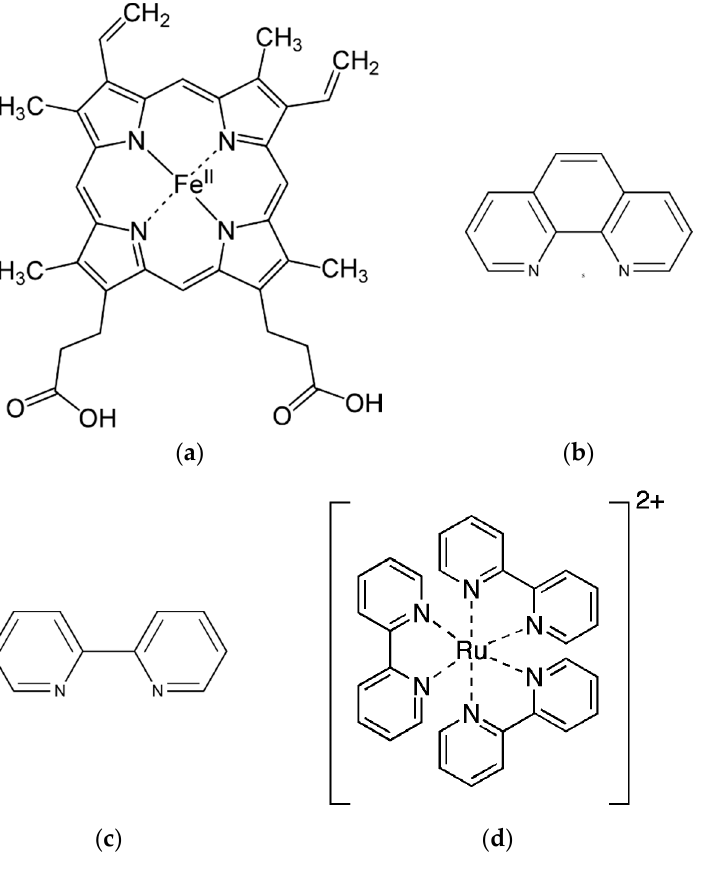
Figure 12. Examples of conjugated π orbital systems. ( a ) heme B, ( b ) 1,10-phenanthrolene, ( c ) 2,2 ′ -bipyridine, ( d ) ruthenium(II) tris (2,2 ′ -bipyridine).